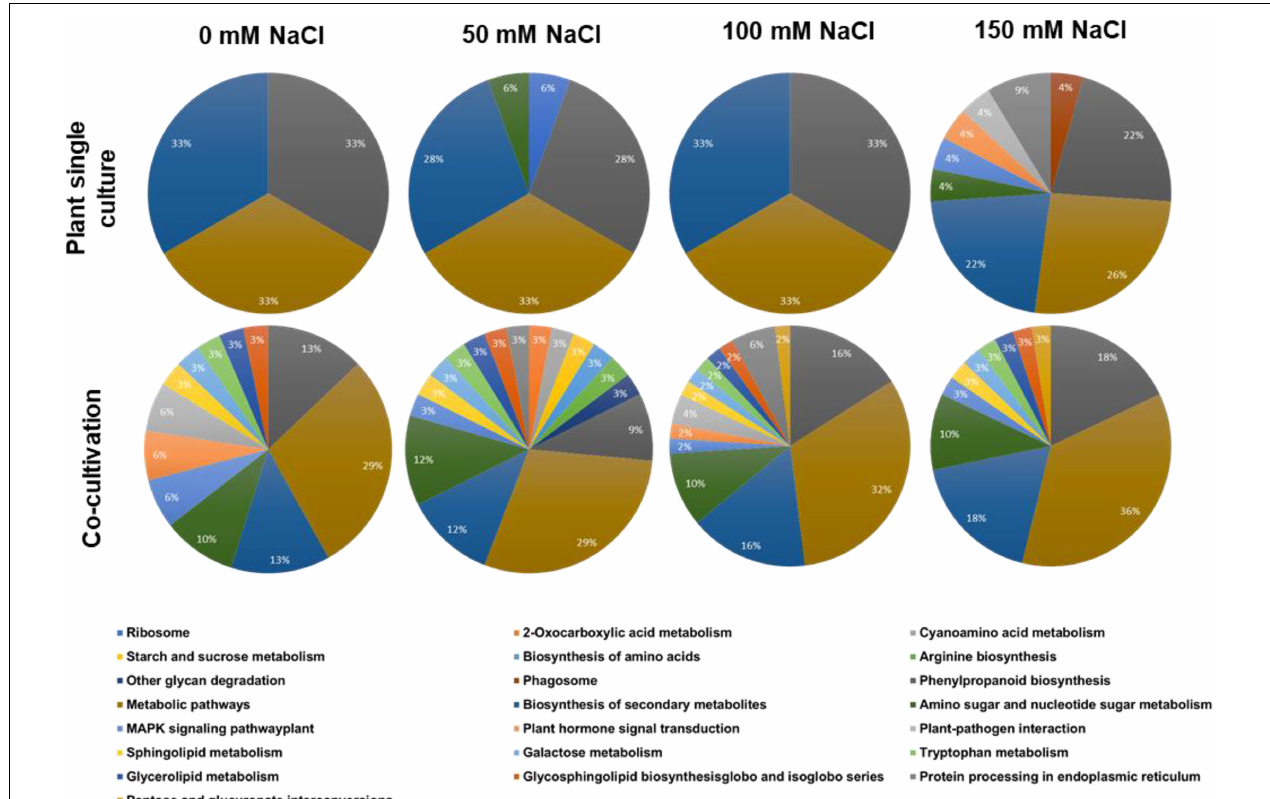
FIGURE 2 | Annotation of the identified plant proteins according to the biological pathways (GO annotation). The plants were either grown alone or in co-culture with the fungus in media supplemented with 0, 50, 100, or 150 mM